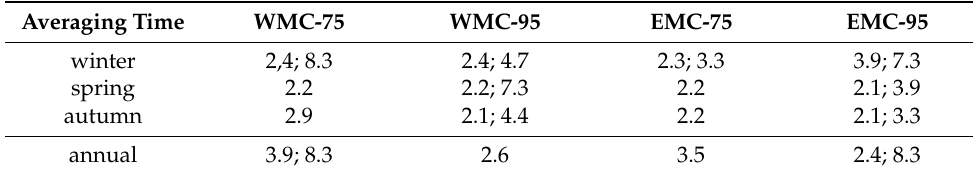
Table 2. Periods (years) of spectral peaks (significant at the 75% confidence level) contributing at least 8% to the dispersion of the seasonal (except summer) and annual frequency of intense/extreme cyclones over the Western and Eastern Mediterranean (WMC-75/WMC-95 and EMC-75/EMC- 95,